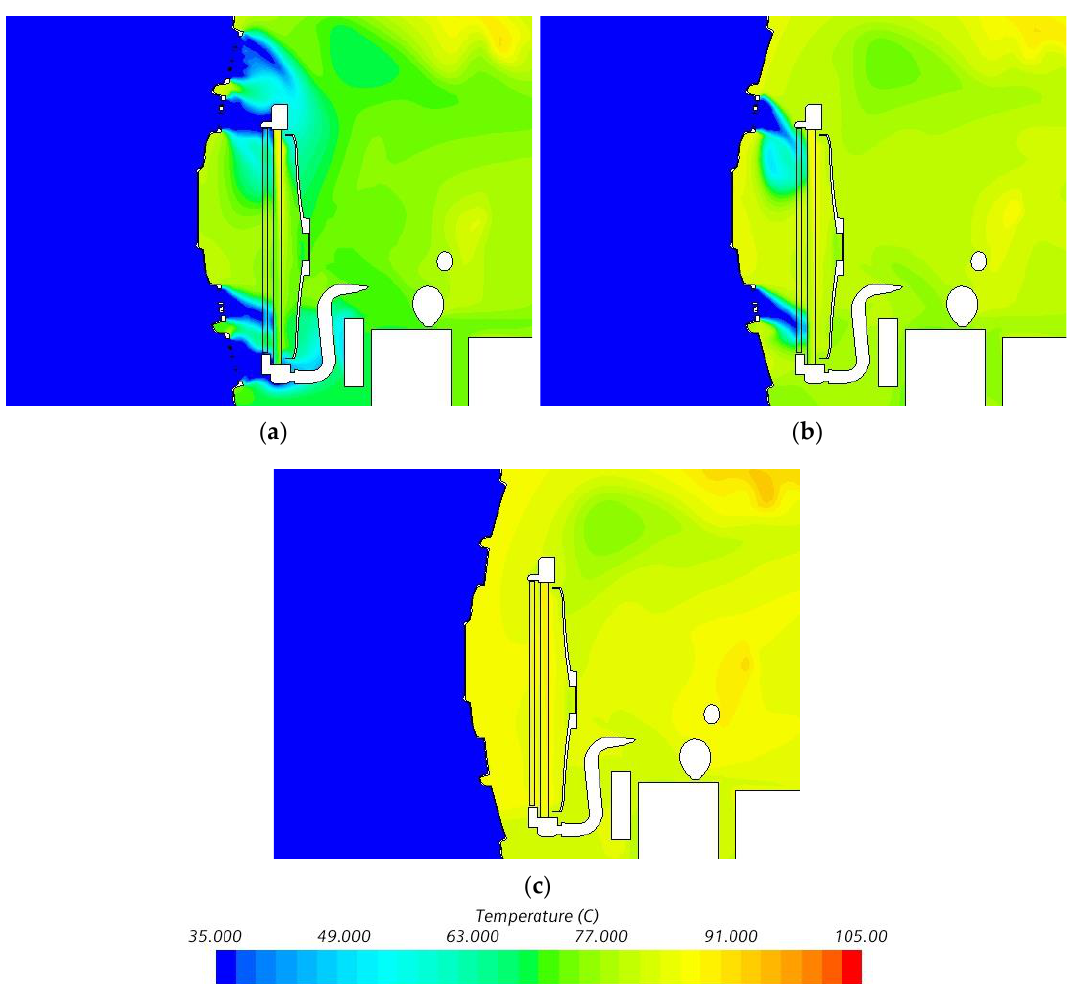
Figure 17. Comparisons of the condenser inlet temperature under different upper grille schemes.